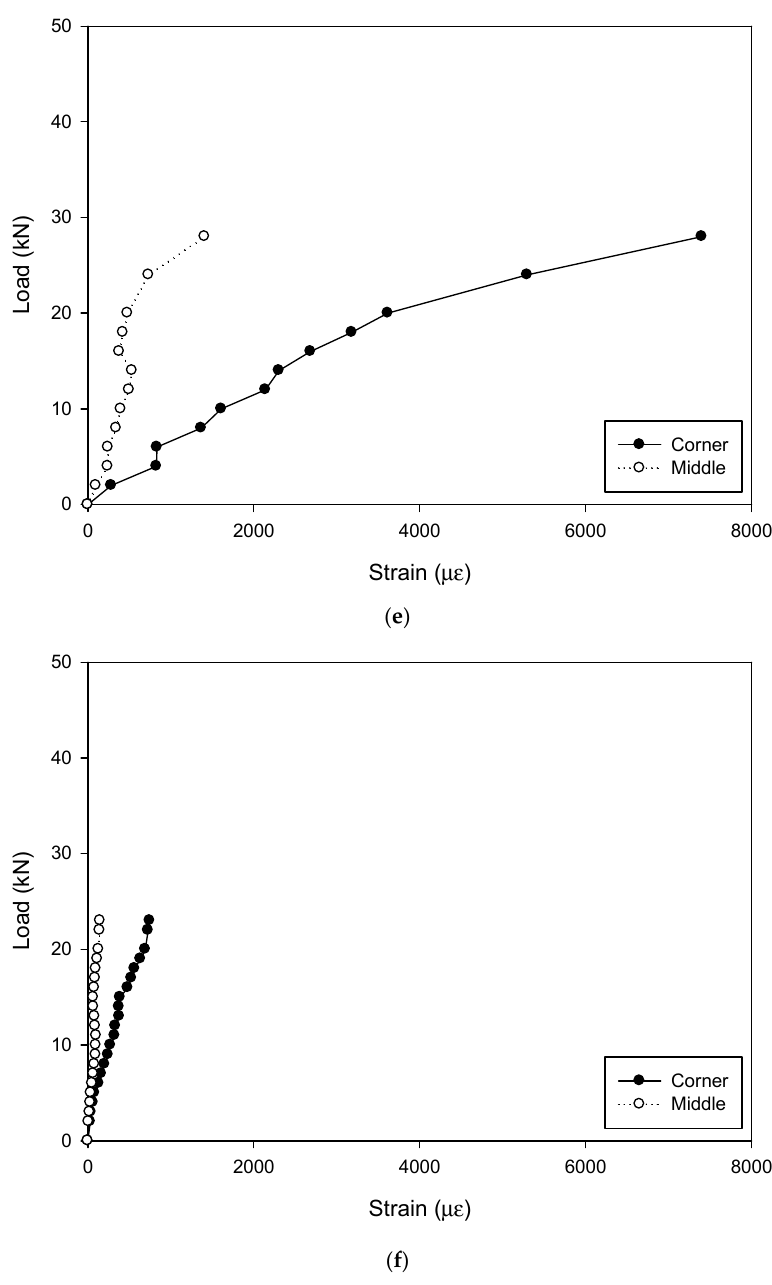
Figure 6. Comparison of the strains on GFRP tubes between at the corner and in the middle of the cross arms: ( a ) Specimen D150-20; ( b ) specimen D150-30; ( c ) specimen D150-40; ( d ) specimen D300-30; ( e ) specimen D300-45; ( f ) specimen D300-60.